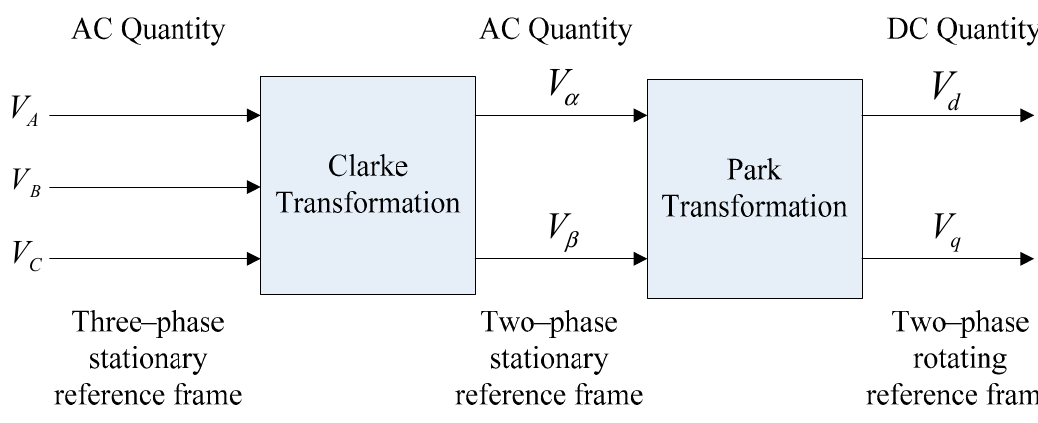
Figure 16. Transformation of the reference frame.